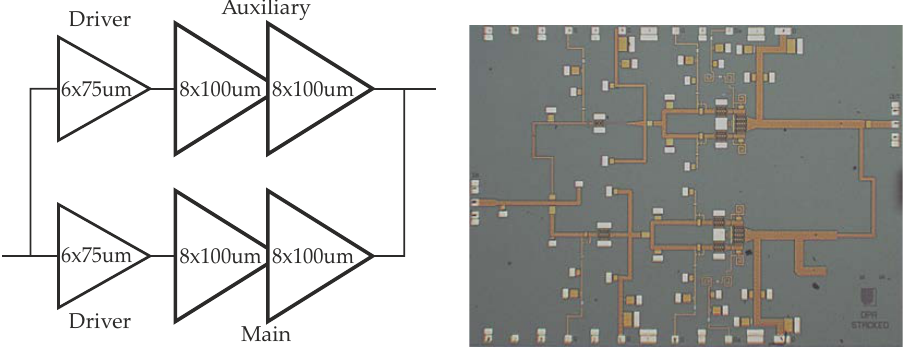
Figure 3. Block diagram ( left ) and layout ( right ) of the DPA in [27] ©IEEE